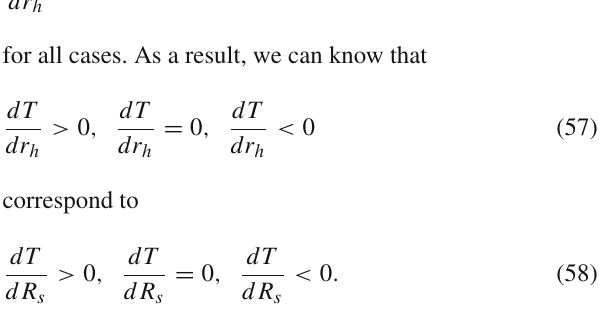
mological constant, zero cosmological constant and a pos- itive cosmological constant. To warrant the universality of the property, we furthermore show the relations between